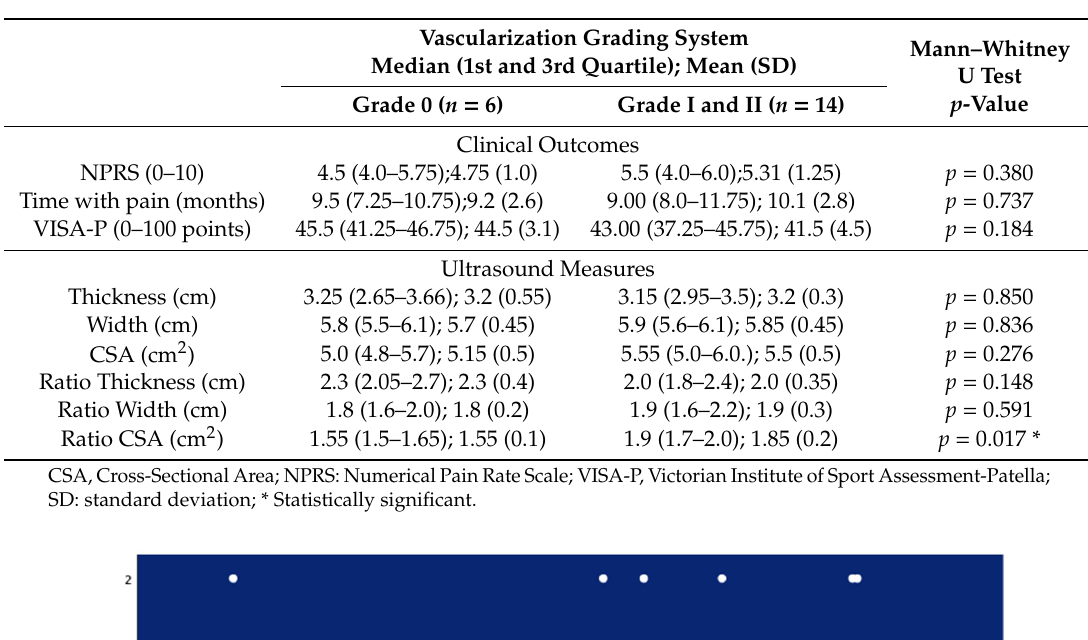
Table 6. Descriptive data and multiple comparisons for ultrasound measures according to the presence / absence of neovascularization.